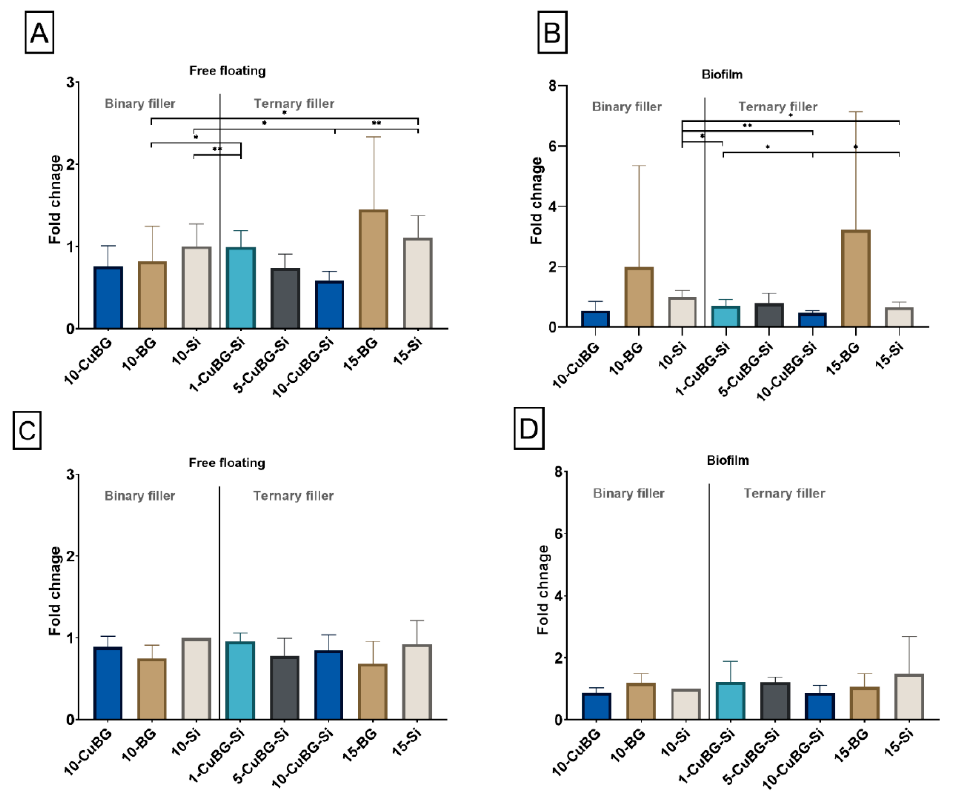
Figure 10. Growth and biofilm formation of Streptococcus mutans and Actinomyces naeslundii . ( A ) Relative amount of free-floating bacteria in a culture of S. mutans after 24 h of incubation in the presence of the respective composites, ( B ) relative amount of biofilm formation by S. mutans on composite surfaces after 24 h of incubation, ( C ) relative amount of free floating A. naeslundii after 24 h of incubation in the presence of composites, and ( D ) relative amount of biofilm formation by A. naeslundii on composites surface after 24 h of incubation. Three samples from each group (n = 3) were used for analysis. Data presented as mean values with standard deviations. (* p < 0.05, ** p < 0.01).